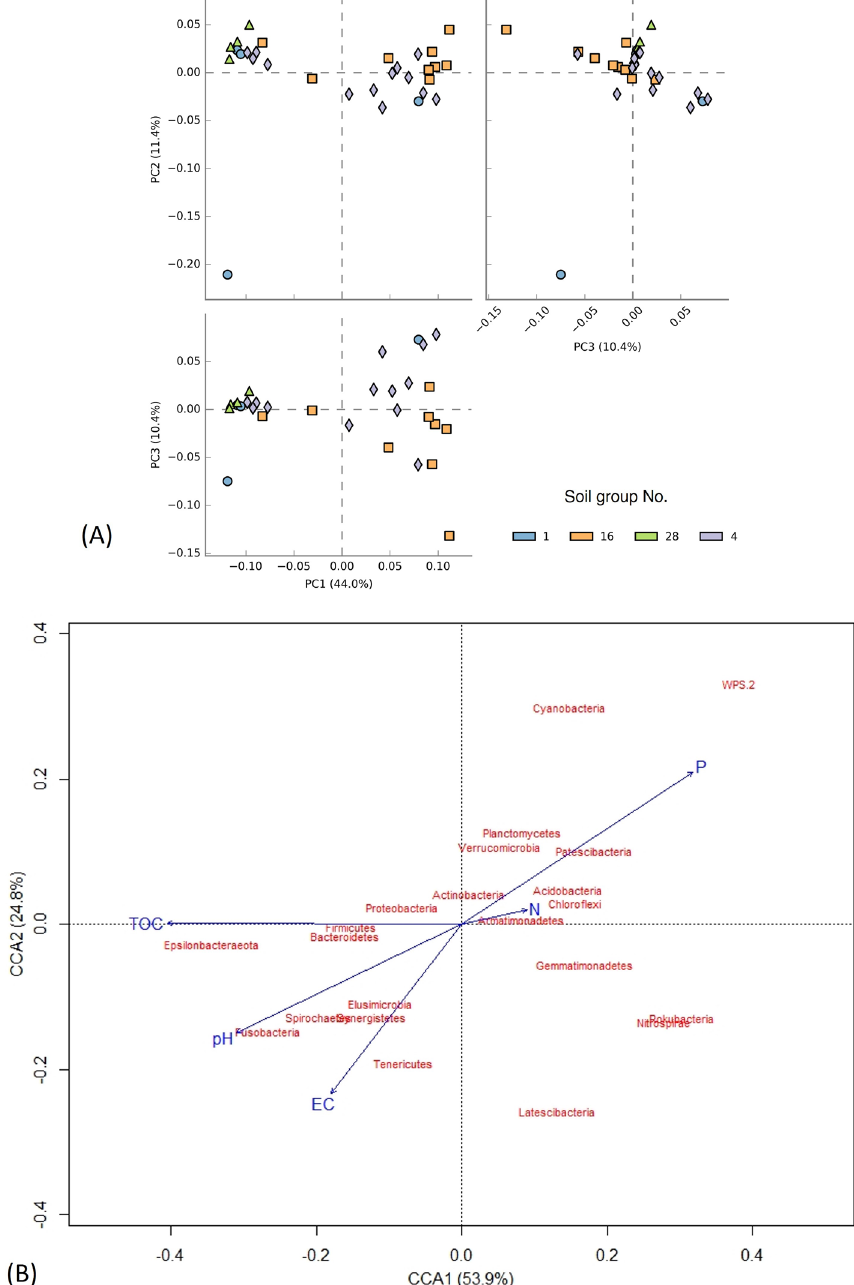
Figure 5. Principal component analysis (PCA) of bacterial phyla from different soil groups ( A ) and canonical correspondence analysis (CCA) of bacterial phyla in response to soil characteristics ( B ). Each soil group No. is represented in blue (No.1), orange (No. 16), green (No.28), and purple (No.